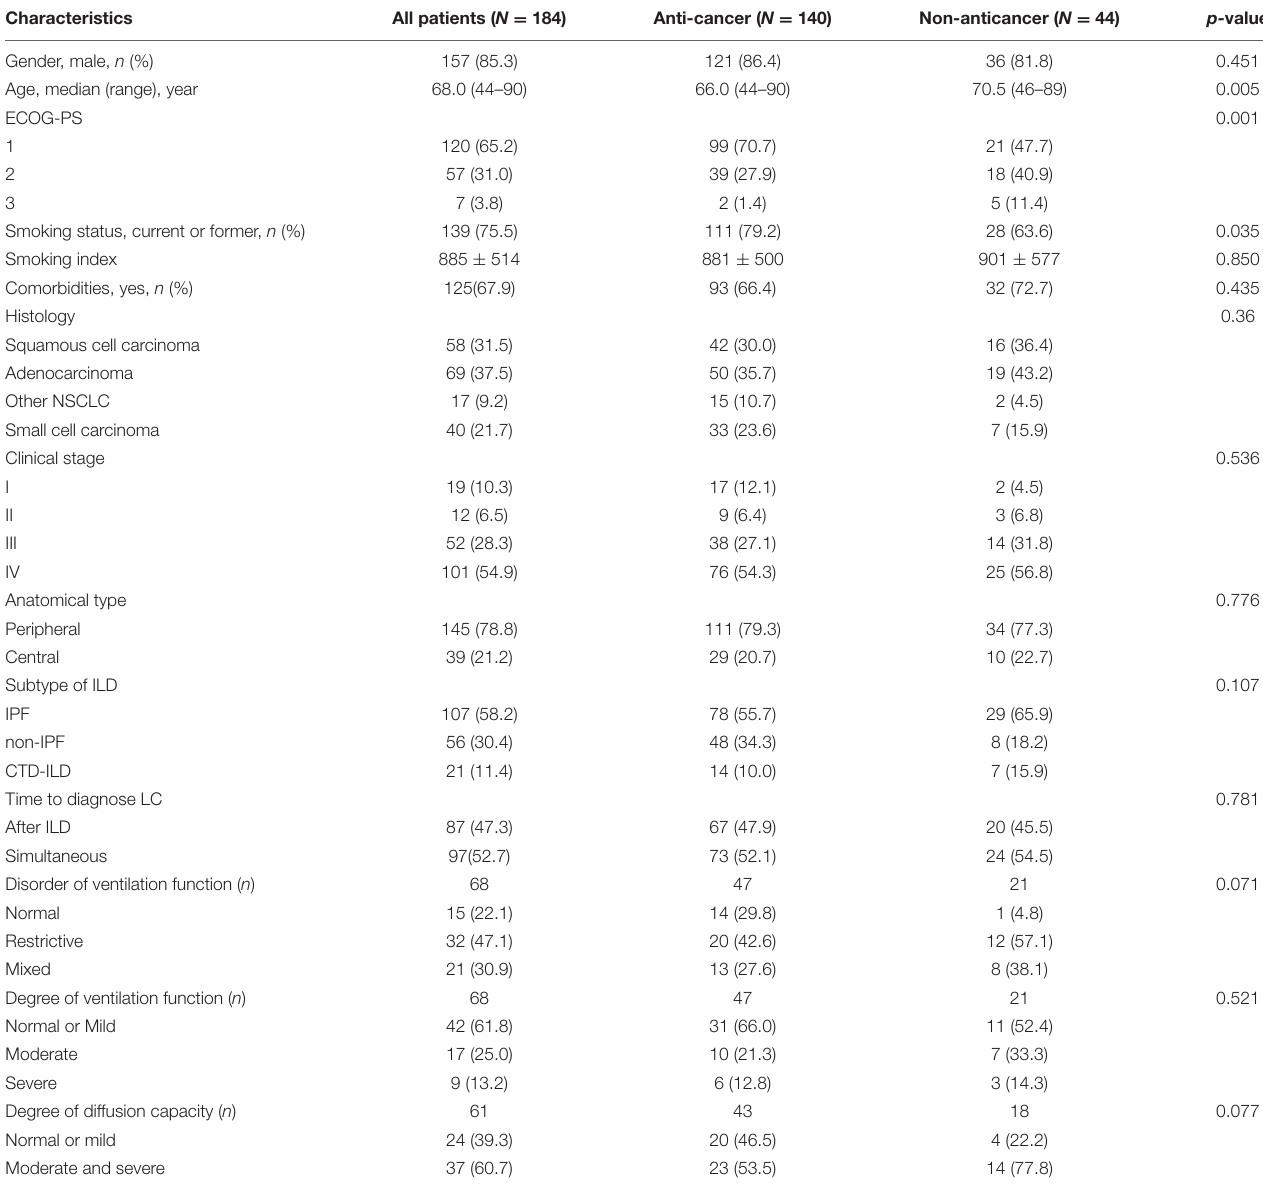
TABLE 1 | Characteristics of anti-cancer and non-anticancer patients with interstitial lung disease and lung cancer (ILD-LC). Characteristics All patients ( N = 184) Anti-cancer ( N =